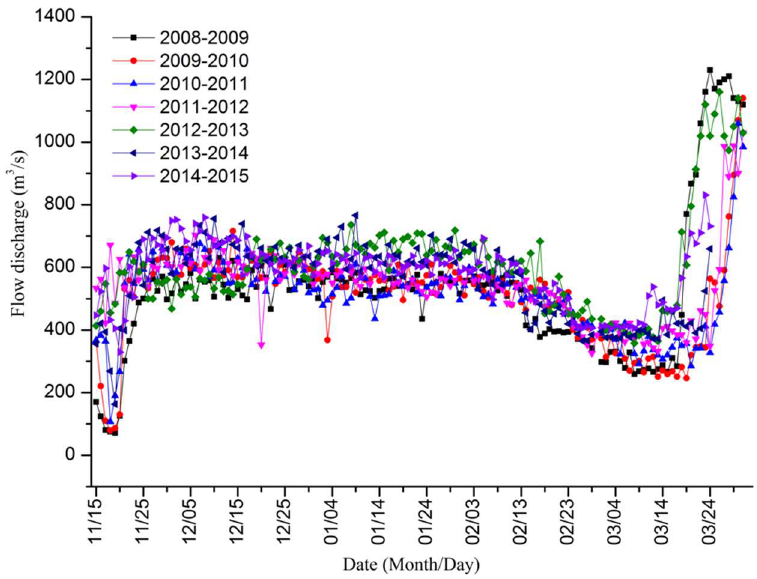
Figure 4. Variation of the daily discharge of the Qingtongxia Reservoir during the ice jam flooding seasons. Table 2. Linear regression results of the discharging processes during the ice jam flooding seasons.